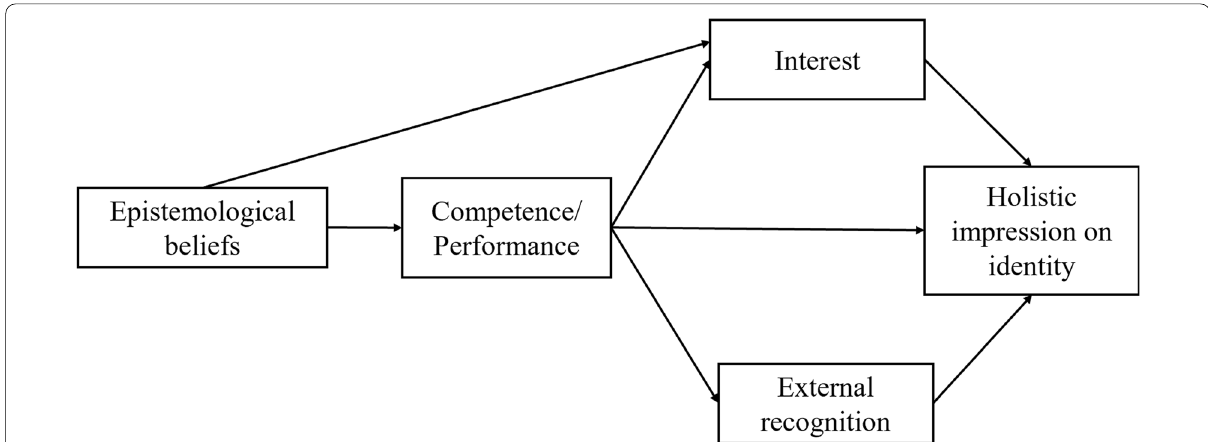
Fig. 2 The relationships between epistemological beliefs and different indicators of science